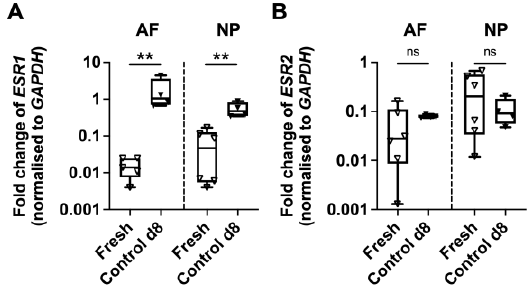
Figure A1. Relative gene expression of oestrogen receptors ( A ) ESR1 and ( B ) ESR2 in cells of the AF and NP from freshly isolated tissues and at day 8 of organ culture under basal control conditions. Levels of mRNA were normalised to the housekeeping gene GAPDH . Results are presented as 2 −ΔCt . Box plots ( n = 4–6 IVDs/group). Mann-Whitney test, ** p < 0.01; ns, non-significant.